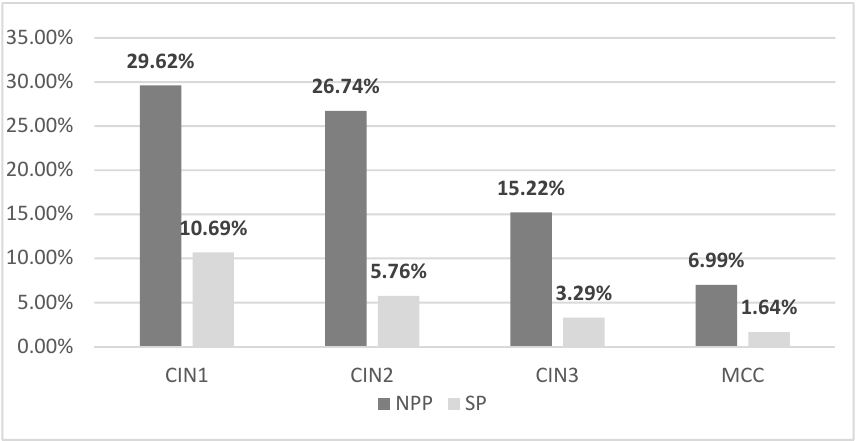
Figure 10. The rate of dysplastic lesions diagnosed using a histopathological examination: the year before the pandemic and the year of the SARS-CoV-2 pandemic in both clinics of the Emergency County Hospital. CIN: cervical intraepithelial neoplasia; MCC: microinvasive cervical cancer; NPP: non-pandemic period; SP: SARS-CoV-2 period.